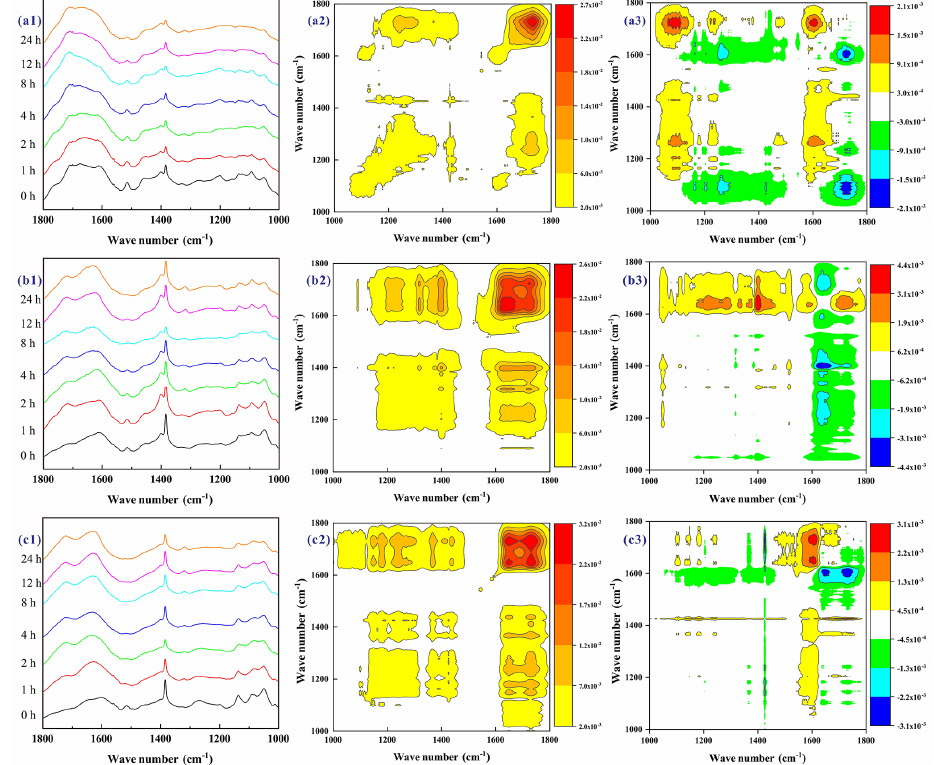
Figure 5. FTIR spectra, and the corresponding synchronous and asynchronous 2D-FTIR-COS maps for the RS (a1–a3) , CS (b1–b3) , and PW (c1–c3) BrC during the ozone aging